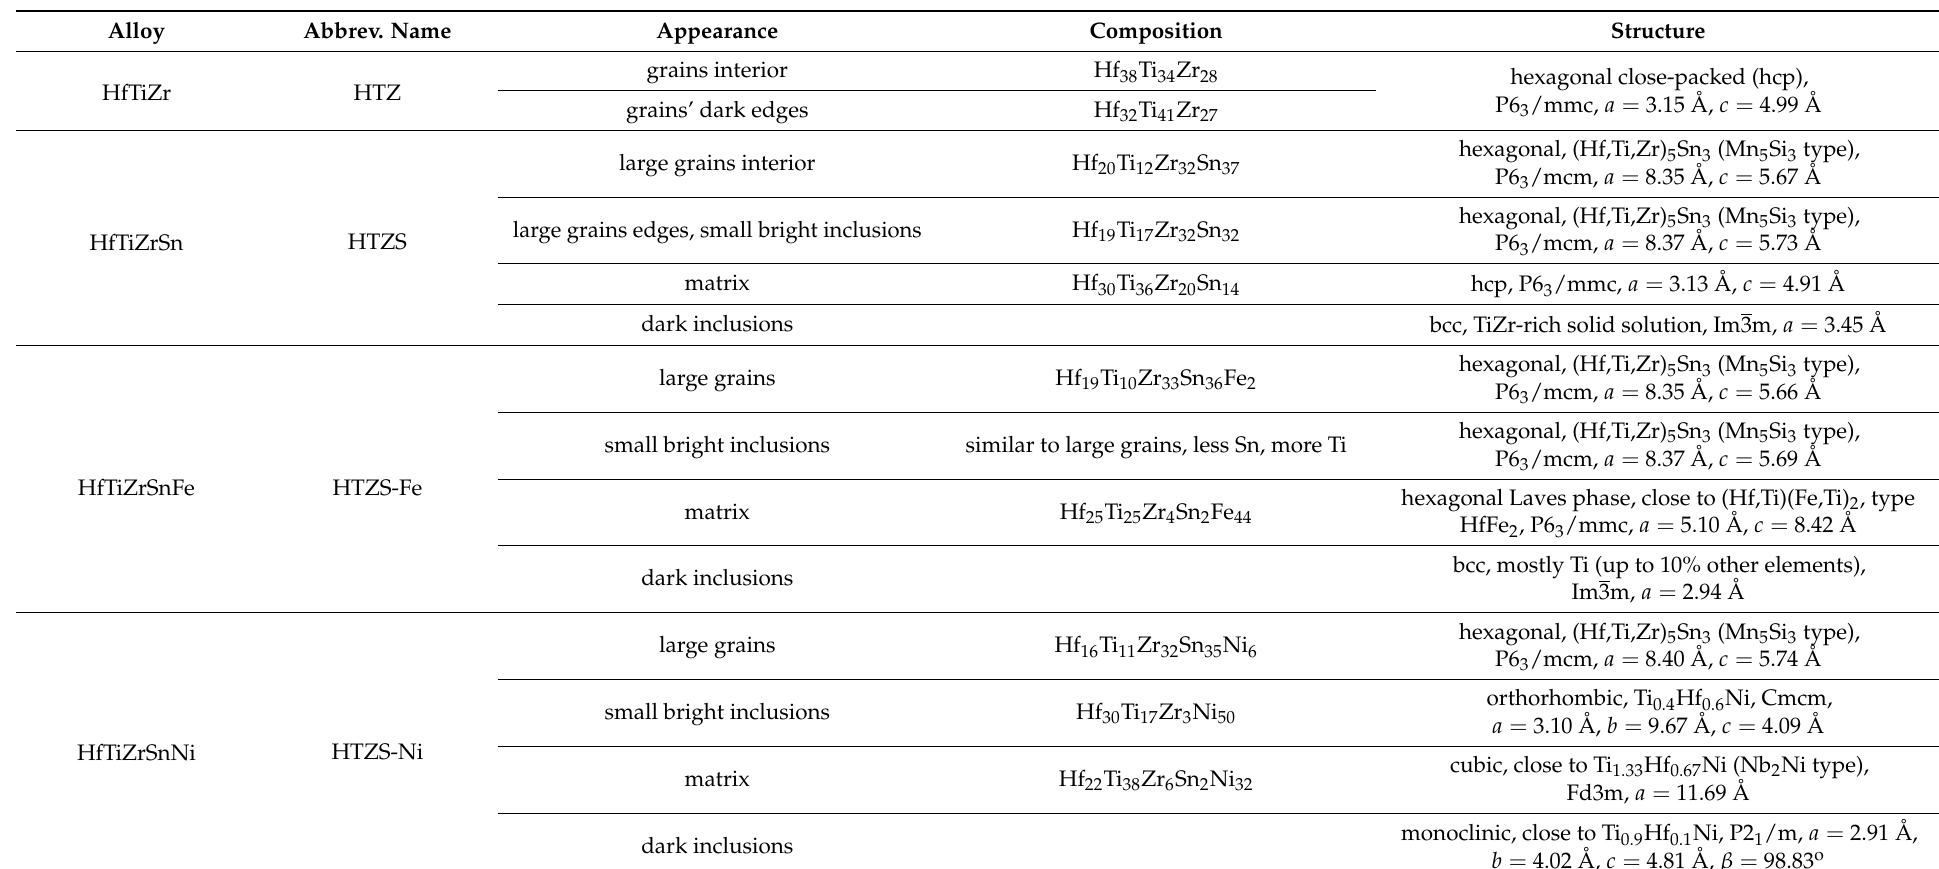
Table 3. List of the investigated alloys, their abbreviated names, chemical composition, and crystallographic parameters. The column “Appearance” describes morphologic appearance of the phase in the SEM-determined